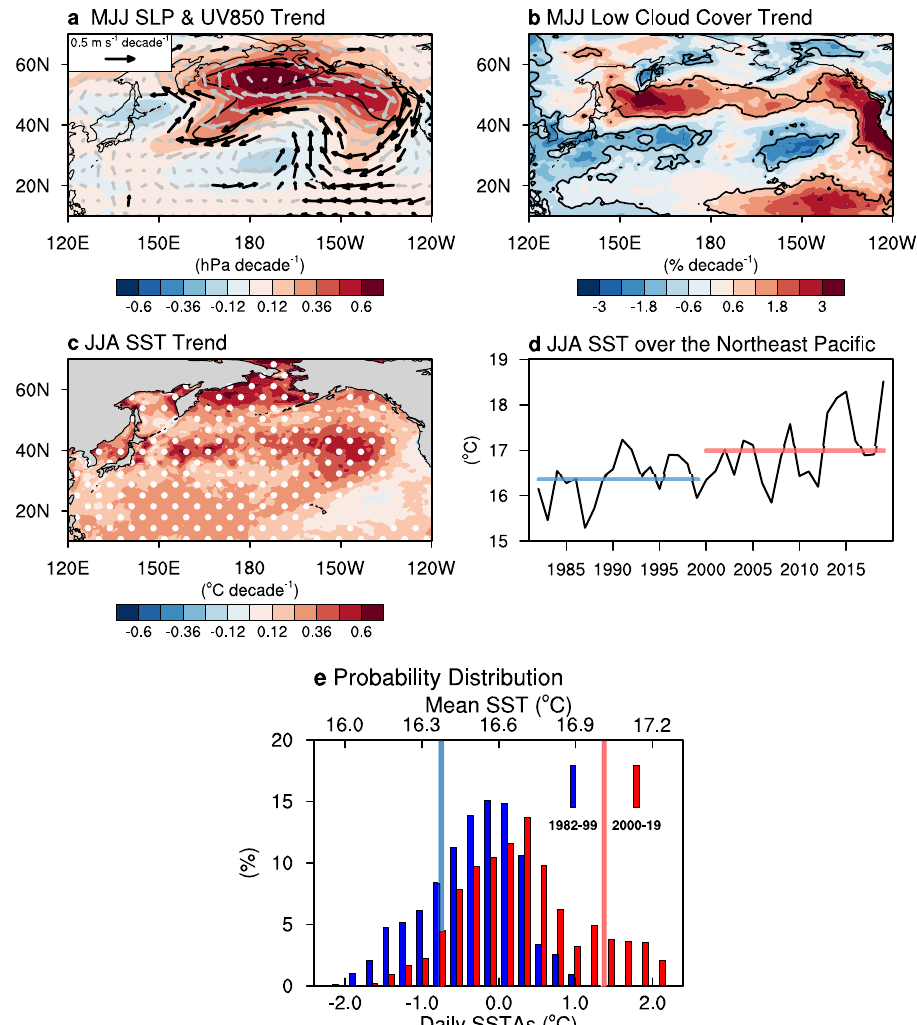
Fig. 3 Trends of atmospheric circulation, low-level cloud cover, SSTs and the probability distribution of daily SST obtained from reanalysis and observational-based datasets. Trend map of a SLP (hPa decade − 1 ) and 850-hPa winds (in m s − 1 decade − 1 ), b LCC (% decade − 1 ) during MJJ and c SST (°C decade − 1 ) during JJA for 1982 – 2019.Blackcontour, vector and stippling regions in a – c indicate statistically signi fi cant values atthe 90% con fi dence level based on a two-sided t test (all other vectors are shown in gray). d Time series of mean SST (°C, black line) during JJA in the Northeast Paci fi c. The light blue and red linein d denotes the meanSST valuesfor 1982 – 1999 and 2000 – 2019, respectively. e Probability distribution ofdaily SST anomalies (SSTAs,°Conlower x